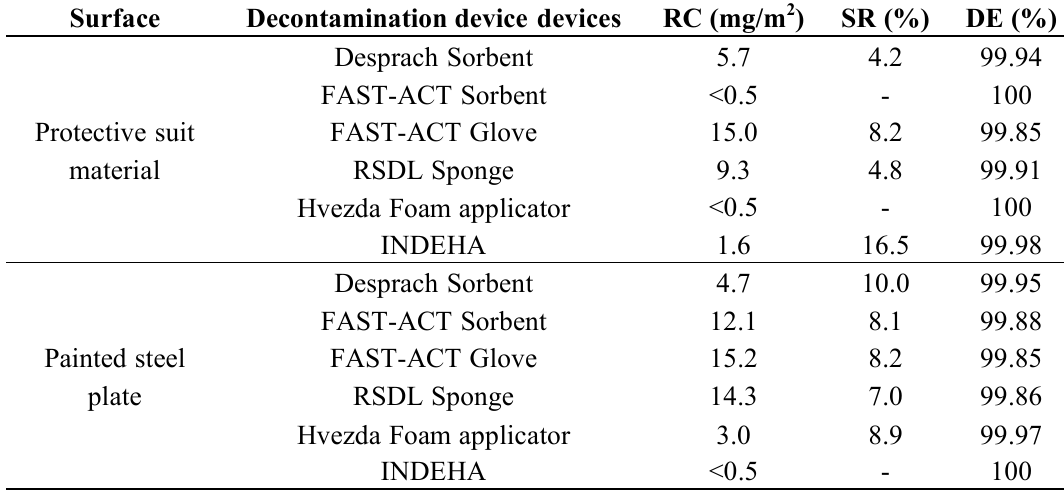
Table 2. Average surface residual contamination values (RC) for surfaces, relative standard deviations (SR) and decontamination efficiencies (DE) for 10 g/m 2 sulfur mustard initial contamination (permissible residual contamination 10 mg/m 2 ).